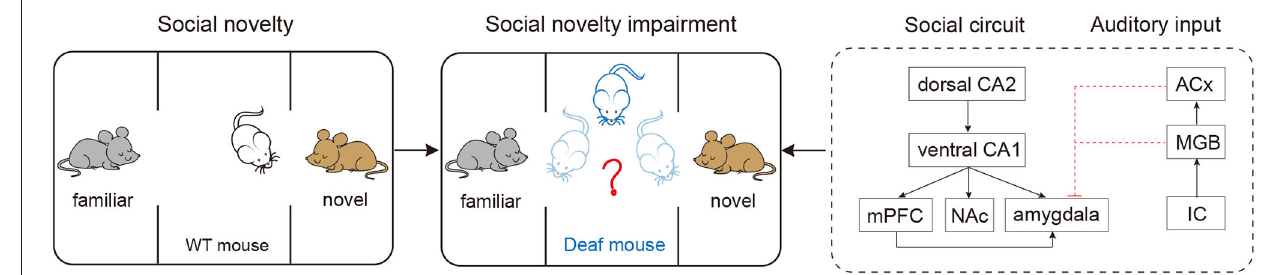
FIGURE 1 | Complete elimination of peripheral auditory input before onset of hearing causes long-lasting impaired social memory in mice. Compared with the wild-type C57 mice ( left panel , normal hearing), the otof − / − mice spent significant reduced time in navigating the novelty (middle panel) , suggesting an impaired social memory. Right panel , A possible neuronal circuit responsible for the impaired social memory in deaf mice; both medial geniculate body (MGB) and auditory cortex (ACx) may have direct projection to amygdale (red dash lines), the projections can be blocked via complete hearing deprivation. CA1, field CA1 of hippocampus; CA2, field CA2 of hippocampus; mPFC, medial prefrontal cortex; NAc, accumbens nucleus; IC, inferior